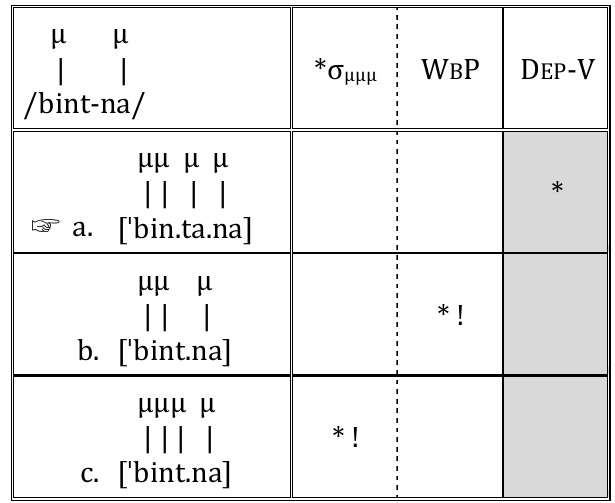
Tableau 2 : Epenthesis occurs to avoid having a trimoraic (super-heavy)